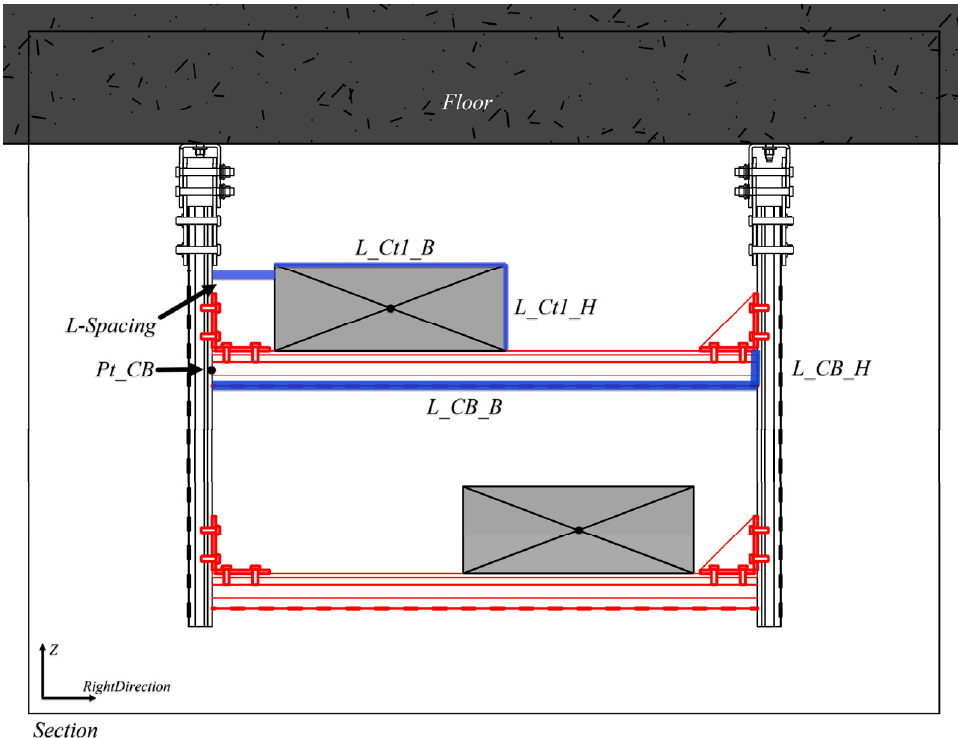
Figure 9. Schematic diagram of the calculation of the cross-bar coordinates and length.